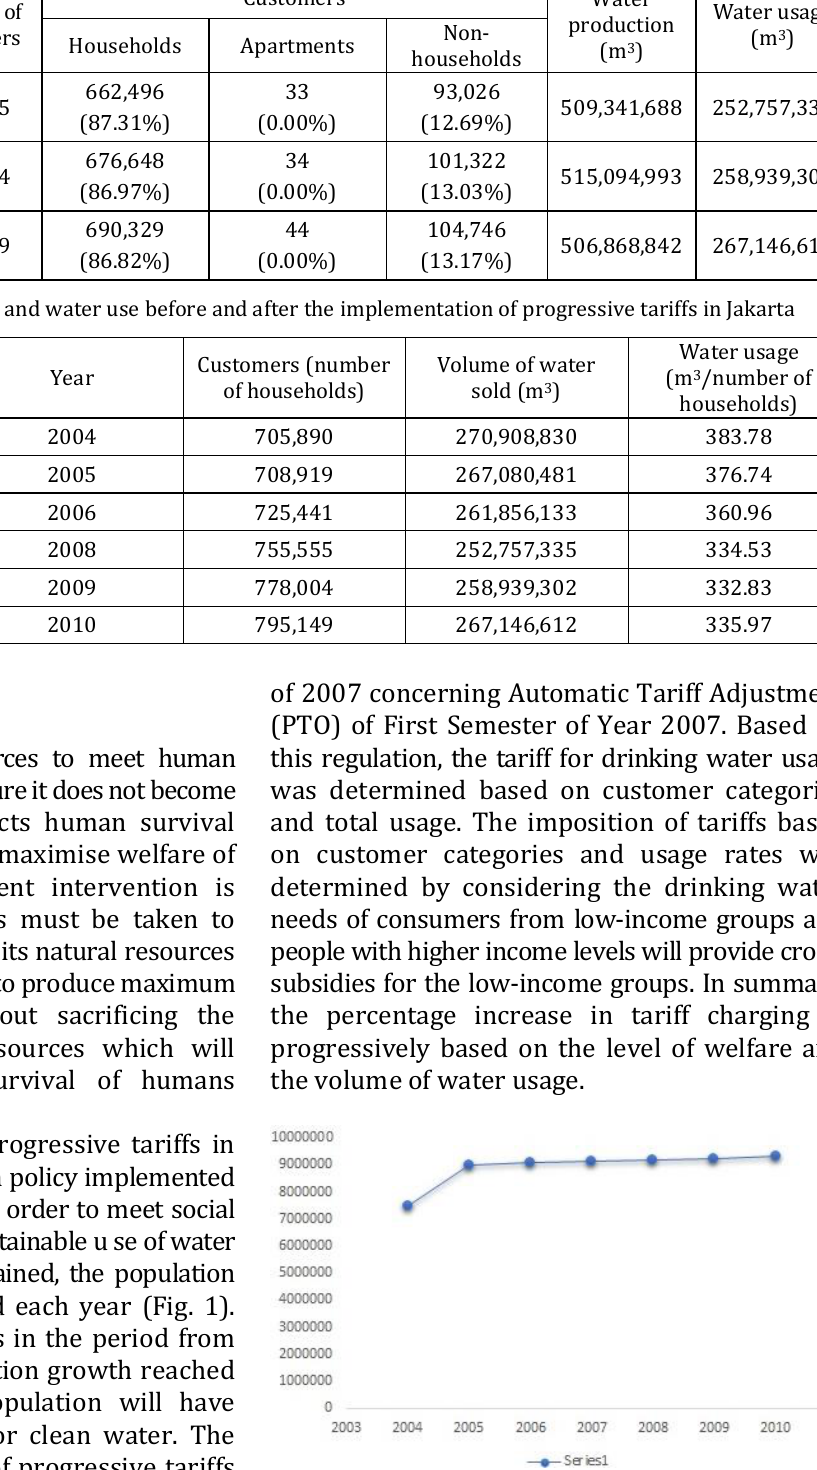
Fig. 1. Population growth in Jakarta from 2004-2010 The regulation of progressive water usage rates has caused differences in usage rates to reach 1395% between group I and group V, specifically in various usage categories, namely 0-10 m 3 , 11-20 m 3 , and 21-30 m 3 . Higher tariff charges for